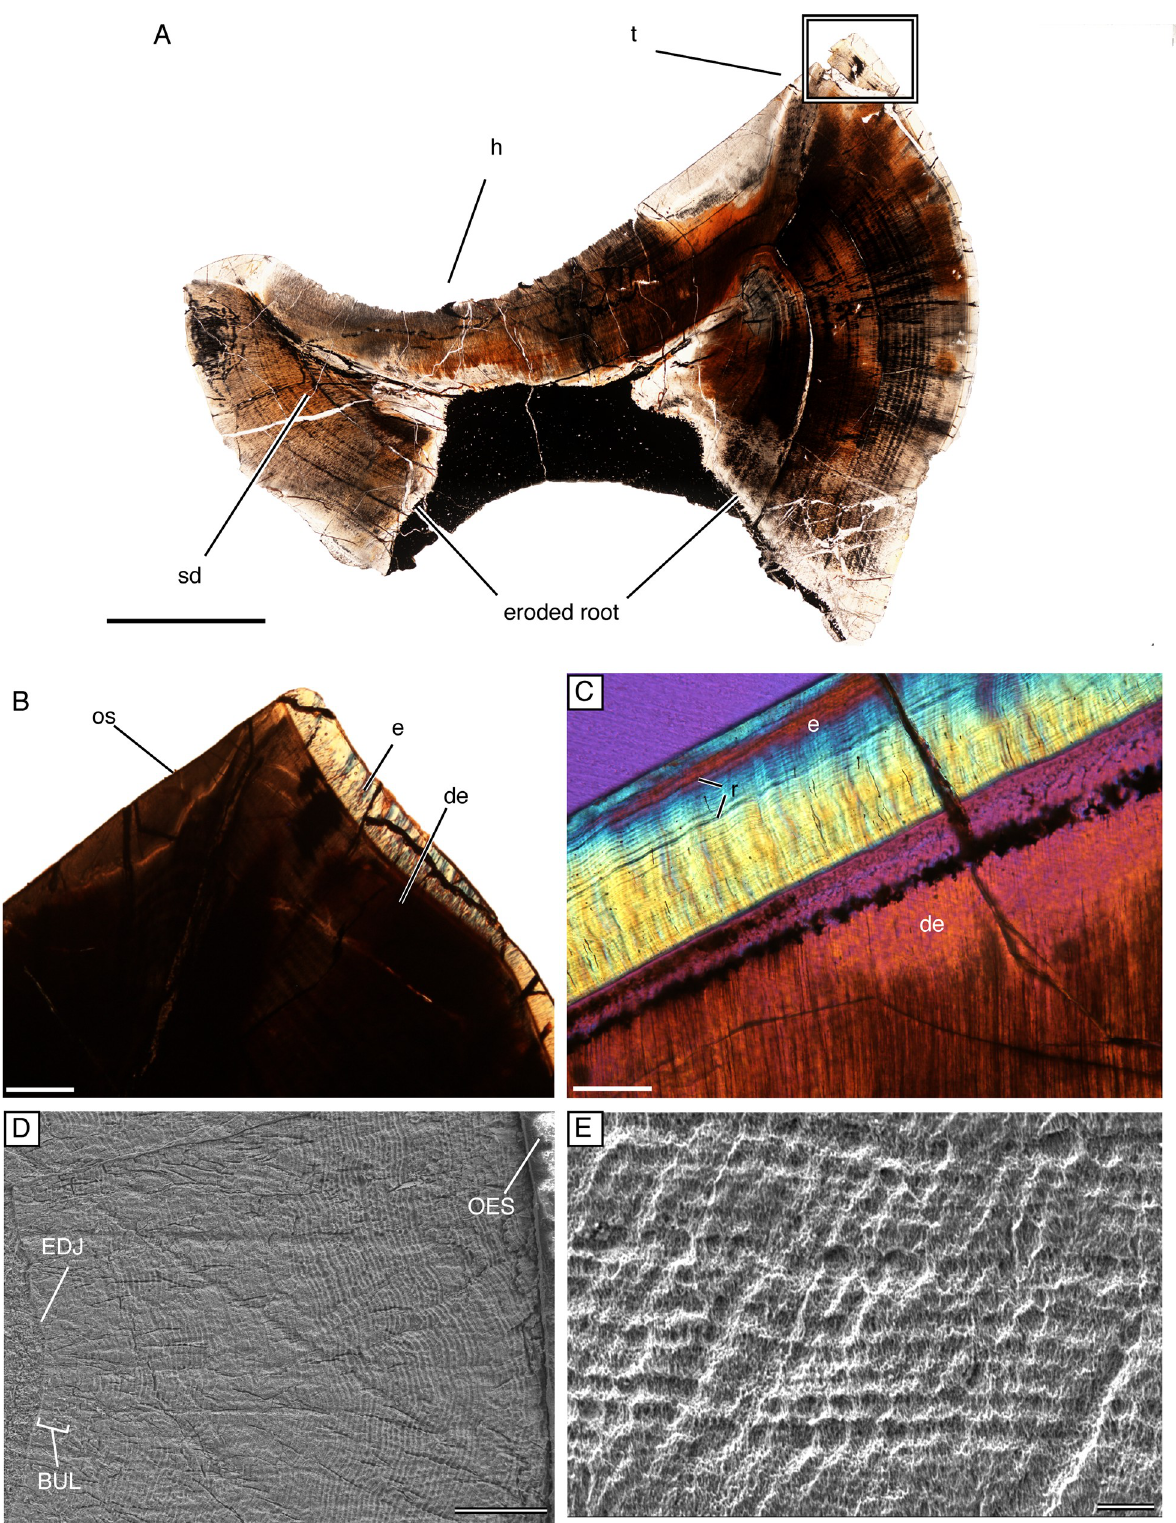
Fig 3. Enamel microstructure of tapinocephalid teeth. (A) Longitudinal thin section of NHCC LB298 that was ejected from the jaw as evidenced by the eroded root and secondary dentine. Labial to the right and occlusal to the top of the page; scale = 5000 μ m. (B) Histology under cross polarized